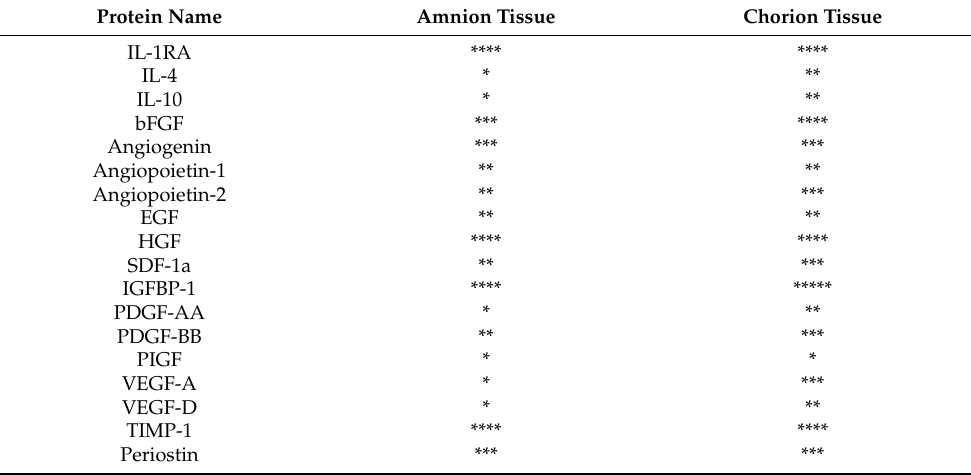
Table 6. Relative level of cytokine and growth factors in amnion and chorion